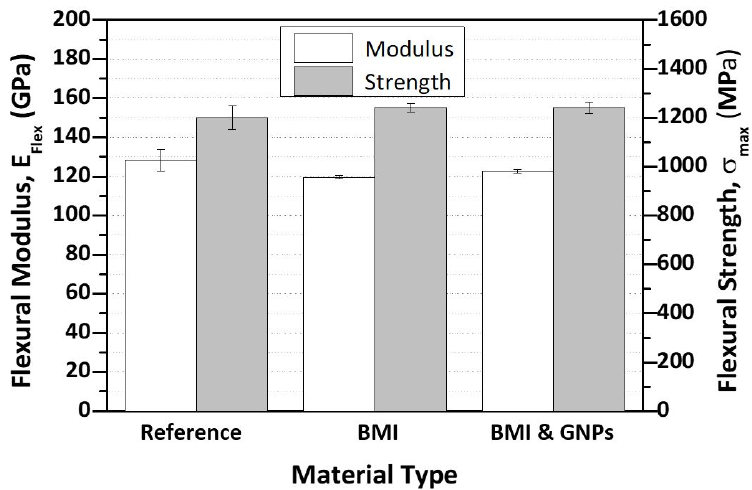
Figure 8. Bar chart diagram providing the flexural properties of the reference and of the two modi- fied CFRPs. modified